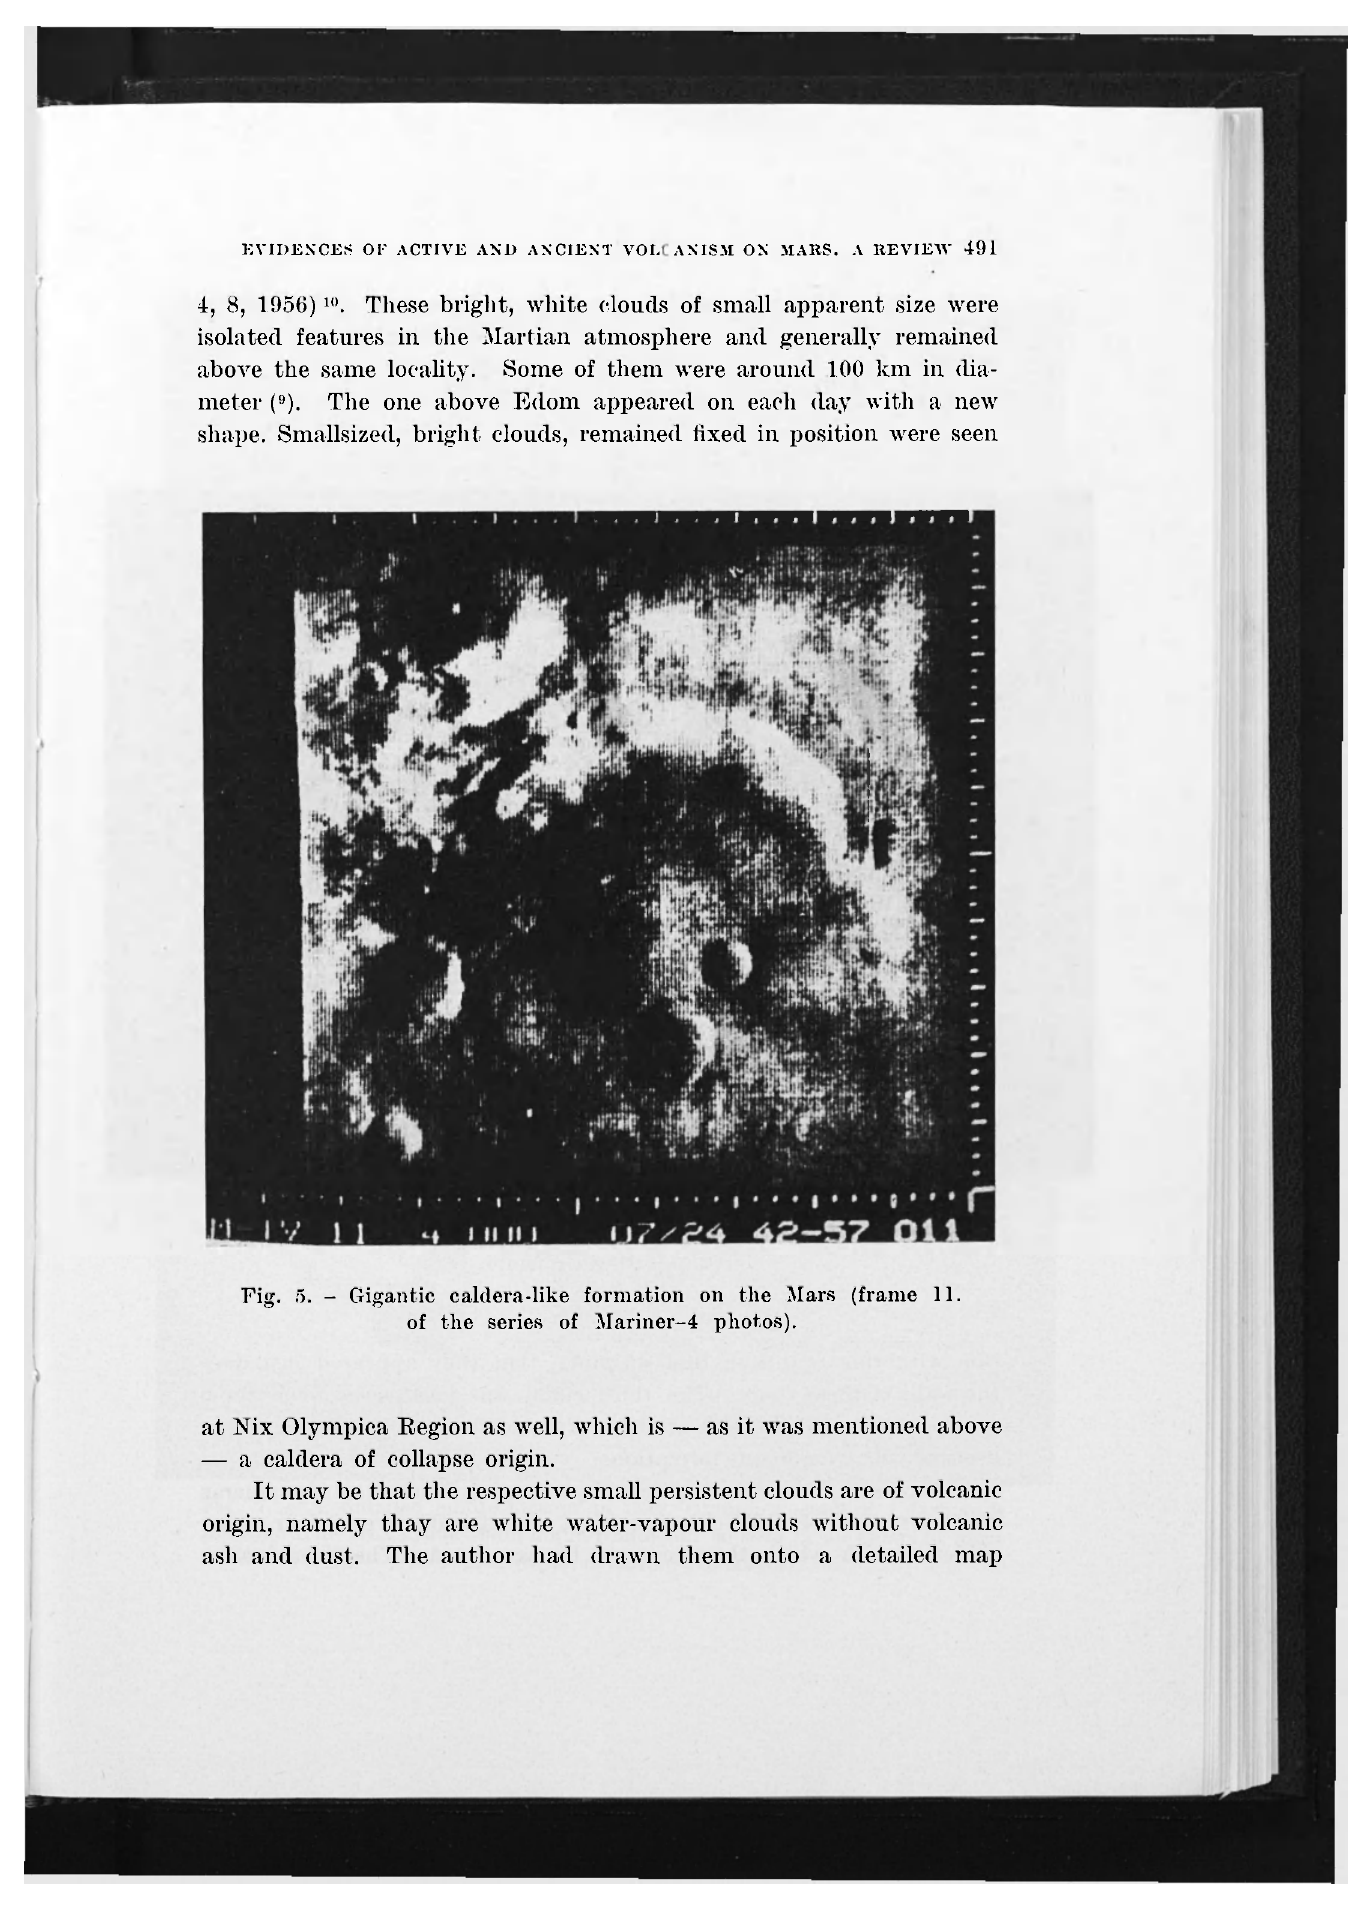
Fig. 5. - Gigantic caldera-like formation on the Mars (frame